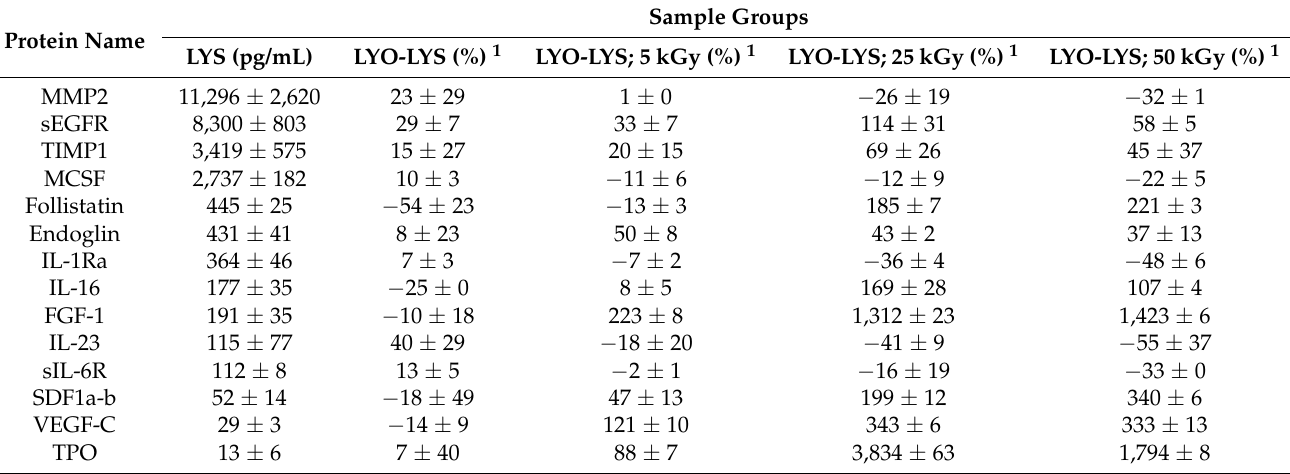
Table 3. Proteomic analysis of samples at different steps of the manufacturing process and following gamma irradiation at various doses. Detected protein concentrations are presented in pg/mL of samples in decreasing relative order of quantitative detection in the fresh cell lysate group. The mean values are presented for each group and each assay condition, along with the corresponding standard deviations. kGy, kiloGray; LYO-LYS, lyophilized cell lysate fraction; LYS, lysate